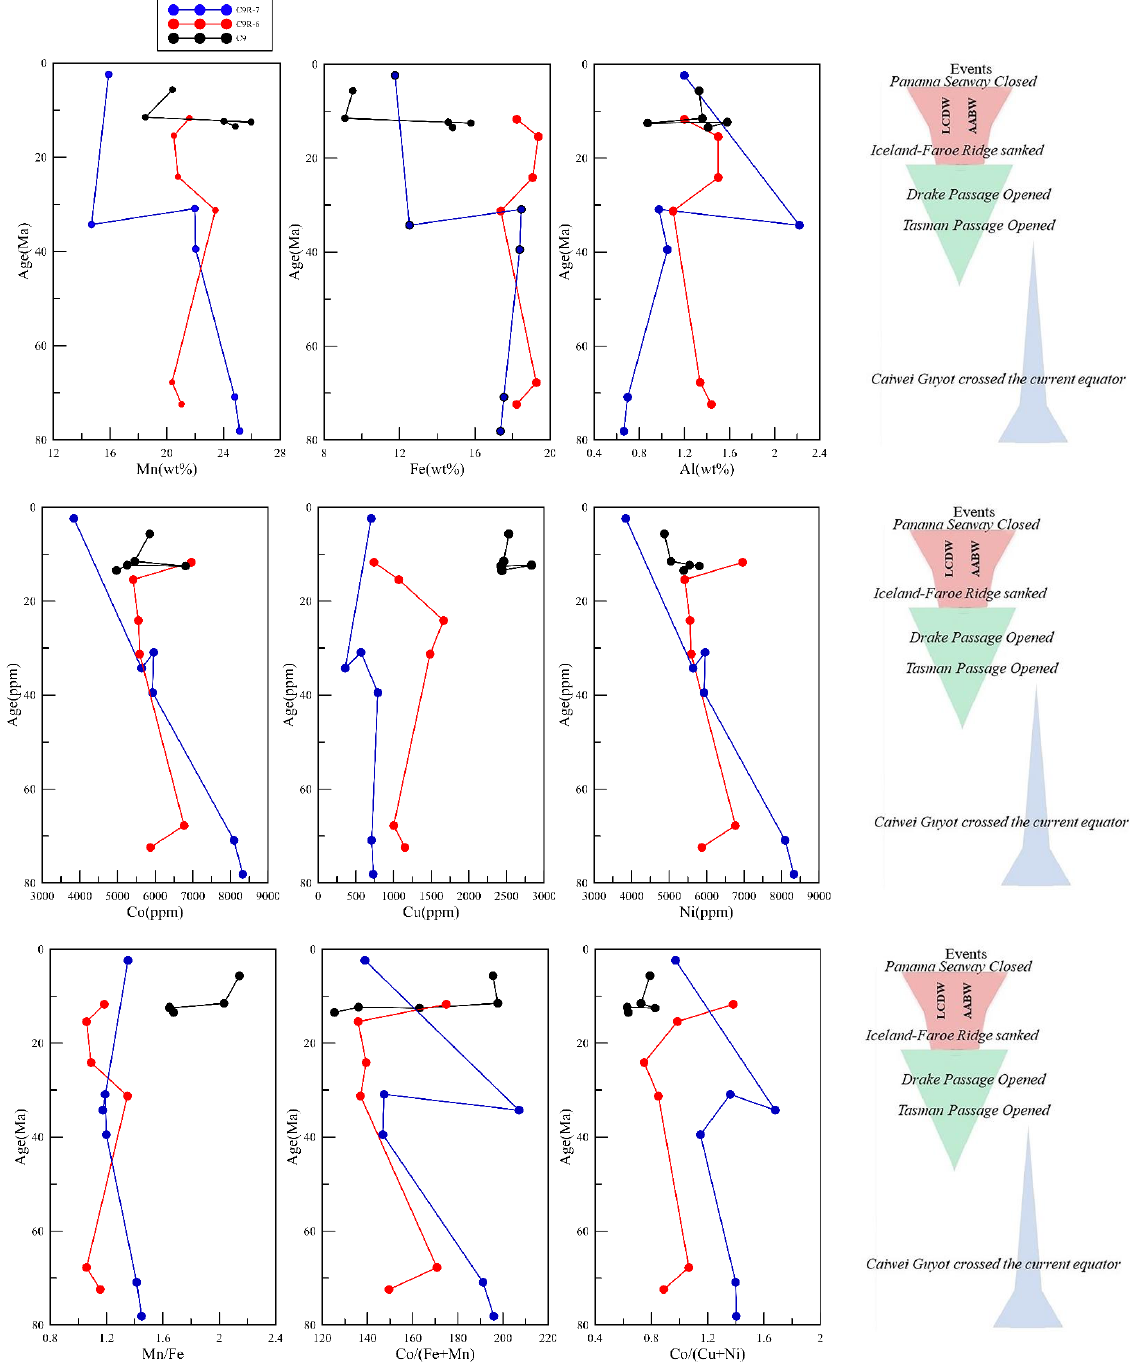
Figure 6. Geochemical profile of elements through ferromanganese deposits on Cawei Guyot. Major paleoceanographic and tectonic events are identified on the right. Blue color represents paleoceanographic and tectonic events “Caiwei Guyot crossed the current equator at about 70Ma”; green color represents paleoceanographic and tectonic events “Drake Passage and Tasmanian Passage opened”; red color represents paleoceanographic and tectonic events “Iceland - Faroe Ridge sanked, LCDW and AABW strengthened, and Panama Seaway closed”.